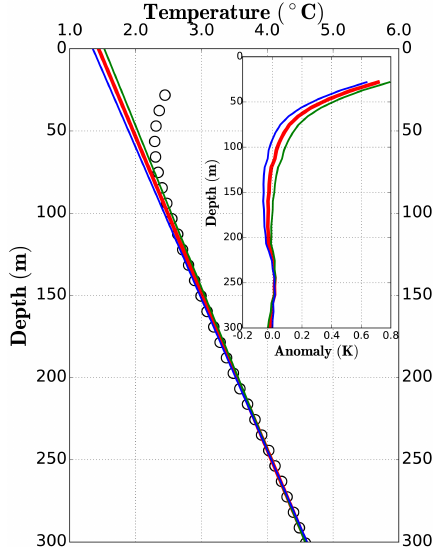
Figure 1. Temperature profile measured at Fox Mine (CA-9519), Lynn Lake, northern Manitoba, Canada. Main panel: measurements are shown in circles T ( z ), the red line represents the geothermal steady state, obtained by linear regression of the lowermost 100m, and extrapolated to the surface ( z = 0). Blue and green lines rep- resent the 95% confidence interval from the linear regression. In- set: transient perturbation or anomaly relative to the geothermal steady state (red line) and the 95% confidence interval (blue and green lines). For this site, the geothermal steady state is given by ± 0 . 34 K (cid:48) o z + T 0 = (10 . 51 K ) × z + (1.44 ◦ C ± 0.19 ◦ C) ( z in km km